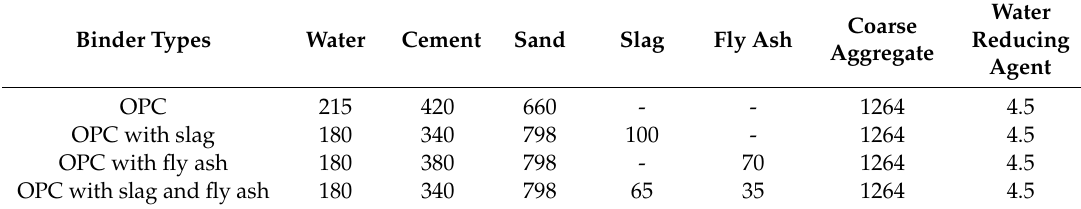
Table 3. Mix proportions of concrete (kg / m 3 ).